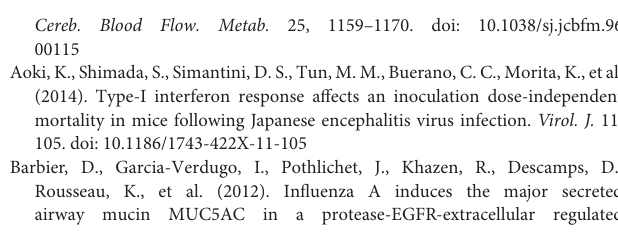
FIGURE 6 | Results were quantified. (B,C) hBMECs were pretreated with 10 µ M AG1478, 25 µ M gefitinib, or DMSO for 2h, followed by JEV P3 infection (MOI = 1) for corresponding times, and the cell lysis was harvested. Western blotting assay was performed to detect the expression of p-EGFR, EGFR, p-STAT3, STAT3, p-ERK, and ERK. Results were quantified. (D) The hBMECs and EGFR-KO hBMECs were infected with JEV P3 (MOI = 1) for corresponding times, and the protein expression was examined using indicated antibodies. Results were quantified. (E) hBMECs were pretreated with U0126 (10 µ M, ERK inhibitor), 17-AAG (1 µ M, STAT3 inhibitor), or DMSO, and then infected with JEV P3 (MOI = 1) for 60 or 120min. The proteins were analyzed with indicated antibodies by Western blotting. (F-H) hBMECs were pretreated with U0126 (10 µ M), 17-AAG (1 µ M), or DMSO followed by JEV P3 (MOI = 1) infection for 24h, and the viral RNA levels (F) , the